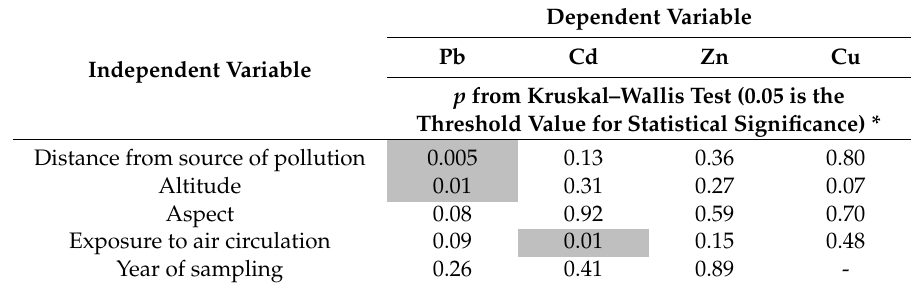
Table 8. The significance of the differences between the heavy metal concentration values by some nonbiological factors. Dependent Variable Pb Cd Zn Cu Independent Variable p from Kruskal–Wallis Test (0.05 is the Threshold Value for Statistical Significance)